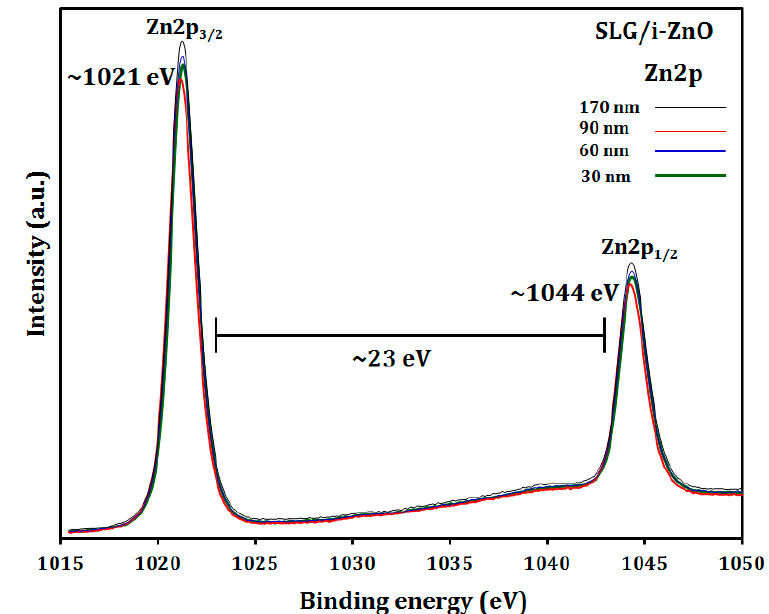
Figure 8. High resolution XPS spectra for the Zn 2p peaks of the SLG/i-ZnO films with different thicknesses in the region highlighted in grey in Figure 7.